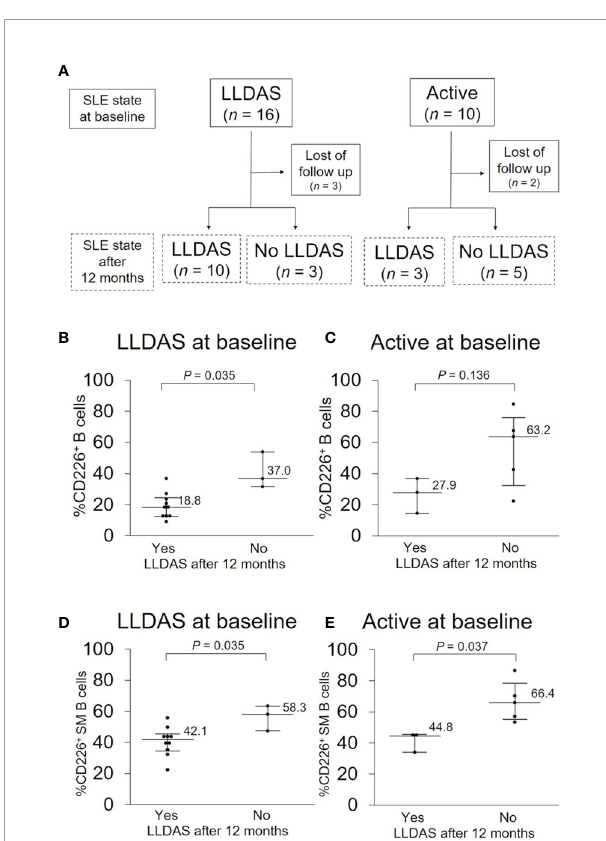
FIGURE 4 | CD226 + B cells at baseline and disease prognosis after 12 months. (A) SLE activity state at baseline and after 12 months. In each activity state at baseline, basal proportions of CD226 + cells in B cells (B, C) and switched-memory (SM) B cells (D, E) were compared between patients who were in Lupus Low Disease Activity State (LLDAS) after 12 months and patients who were not. Each data point represents a single subject. Horizontal lines show the median and error bars represent interquartile ranges. Statistical differences among groups were evaluated using the Mann – Whitney U